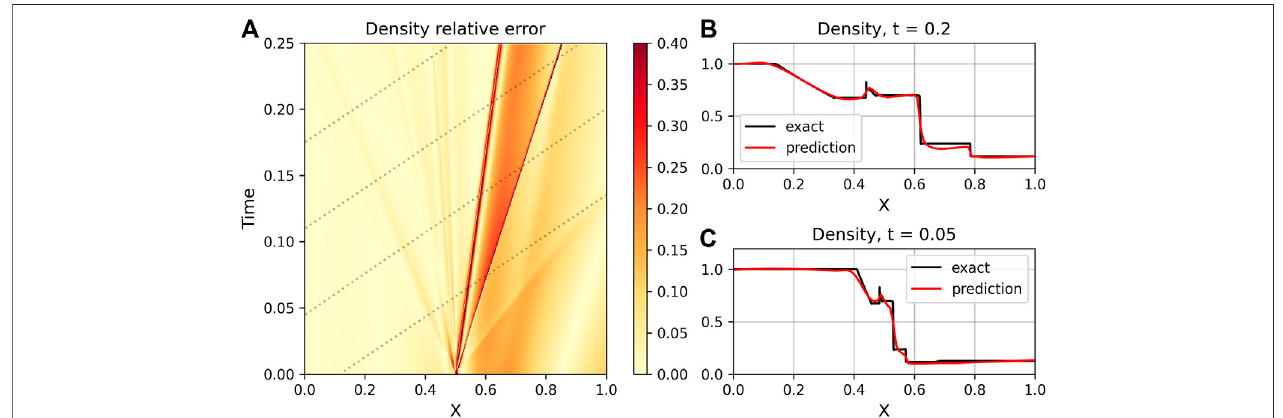
FIGURE 7 | (A) : Density Relative Error (cid:3) ( ρ net − ρ )/ ρ (cid:3) for a PINN trained with four sampled trajectories (dotted lines) on the Brio-Wu shock tube. The greatest error is alongtheshockwaves(onrightside)andinthelower-rightcornerfurthestfromthesampletrajectories. (B,C) :Exact(black)andNN-generatedvalues(red)for ρ at t (cid:1) 0.2 (top) and t (cid:1) 0.05 (bottom). The PINN is able to reconstruct the state, but still has issues around